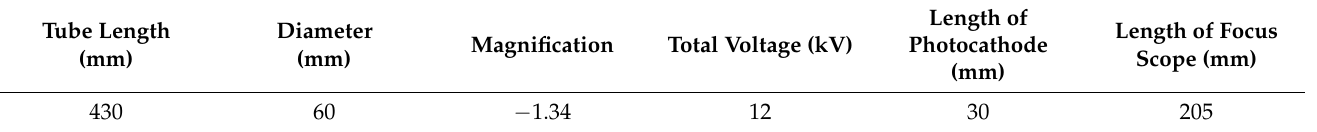
Table 1. Parameters of streak